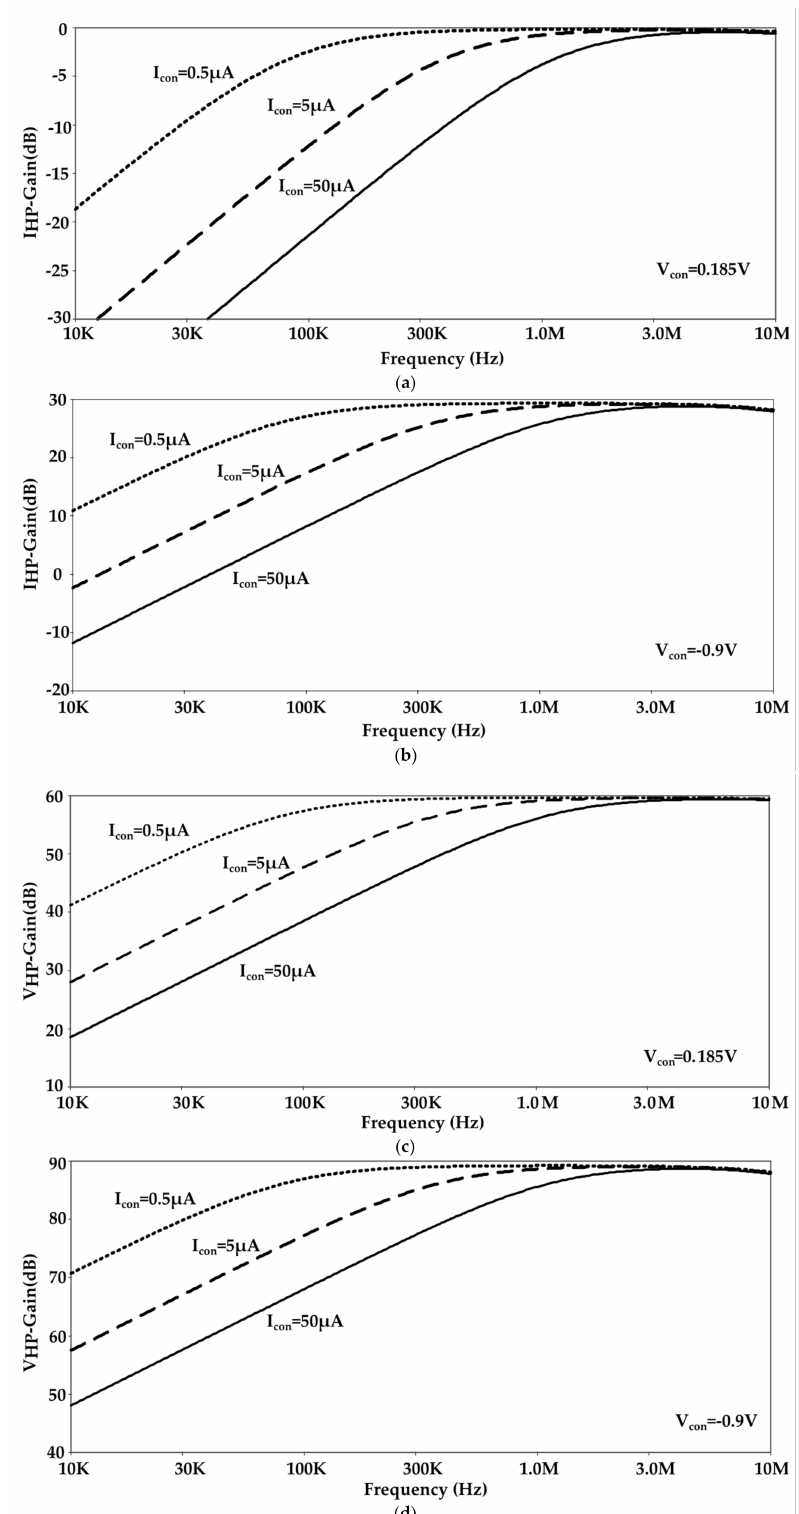
Figure 12. Gain frequency response of ( a ) I HP for V con = 0.185 V ( b ) I HP for V con = − 0.9 V ( c ) V HP for V con = 0.185 V and ( d ) V HP for V con = − 0.9 V at three different values of I con for the filter proposed in Figure